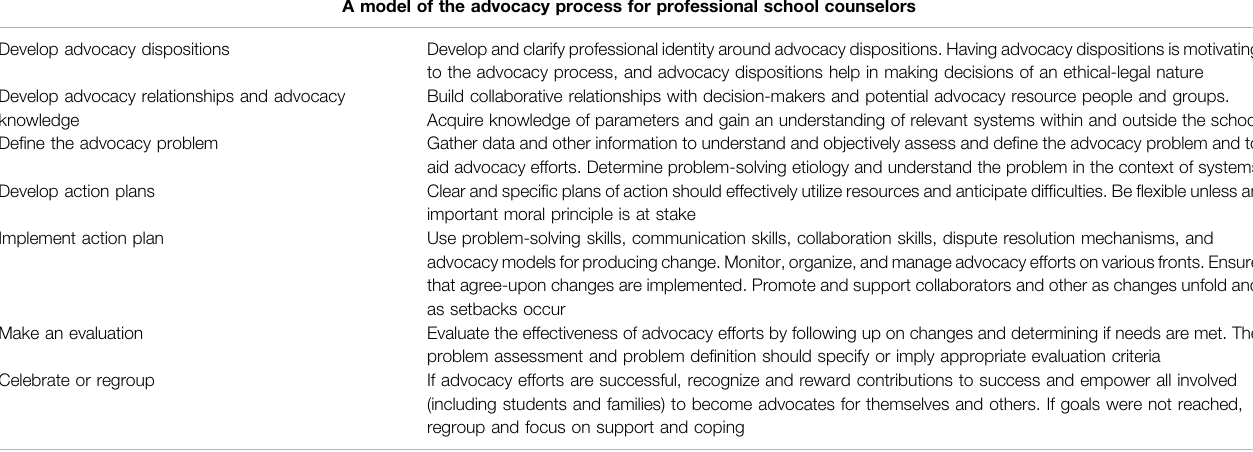
TABLE 1 | model of the advocacy process for professional school counselors (Trusty and Brown, 2005). A model of the advocacy process for professional school